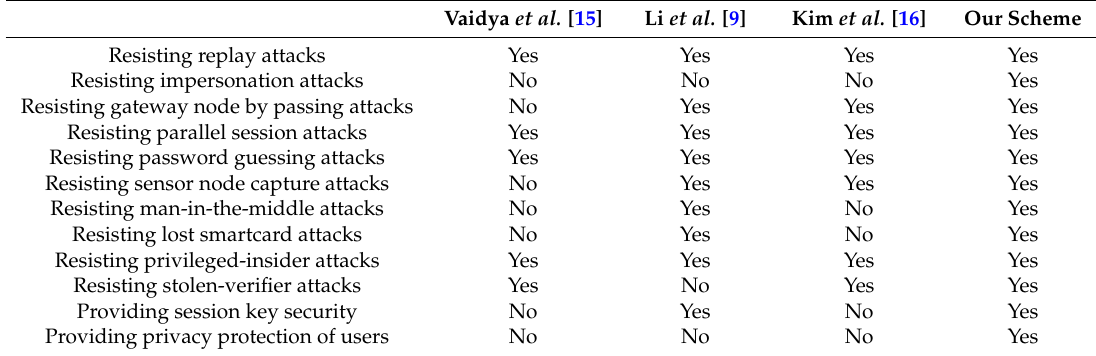
Table 5. The comparisons of the related schemes and the proposed